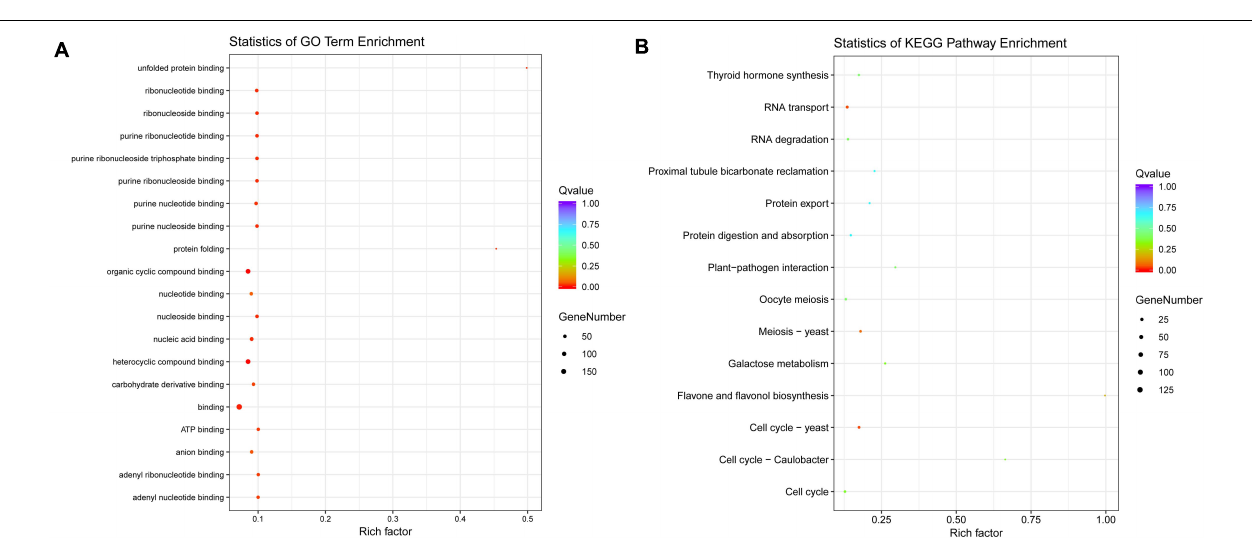
For validation, qPCR was performed on 10 randomly selected sequences. Their gene relative expression, depicted in Figure 12 , shows the similarity of the expression profiles by qPCR to those by bioinformatic